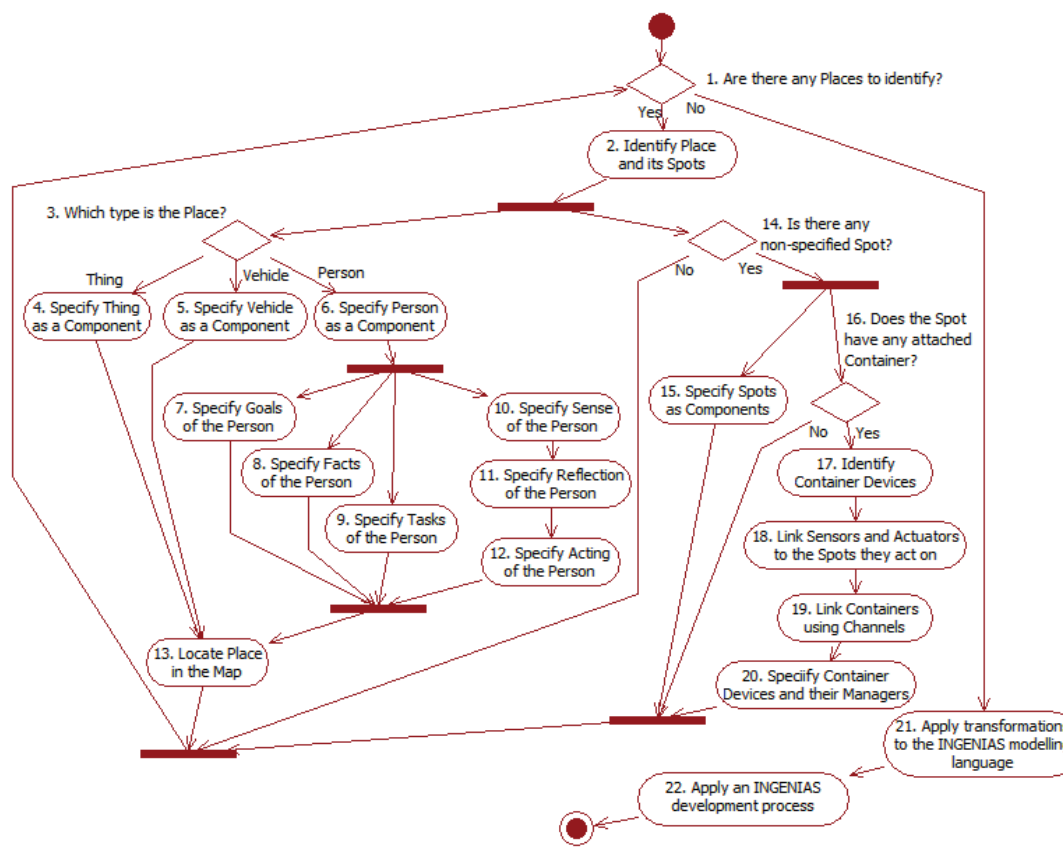
Figure 7. Activity diagram of the development process with the ITSML. Concepts starting with uppercase belong to this